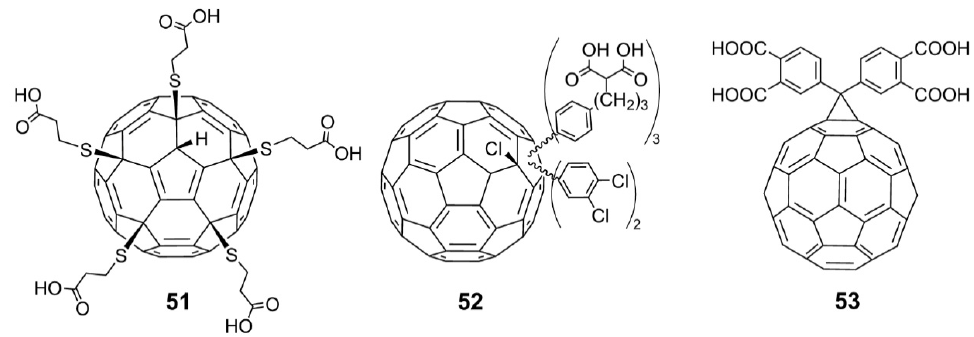
Figure 15. Structure diagram of polycarboxylic fullerene acid derivatives ( 51 – 53 ).